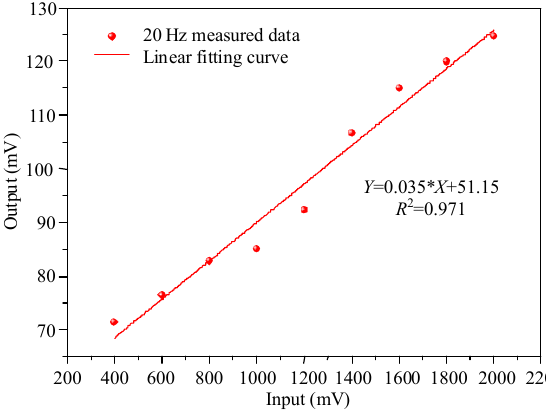
Fig. 5 Measured response at various driving voltages of the vibrator for a vibrating frequency of 20